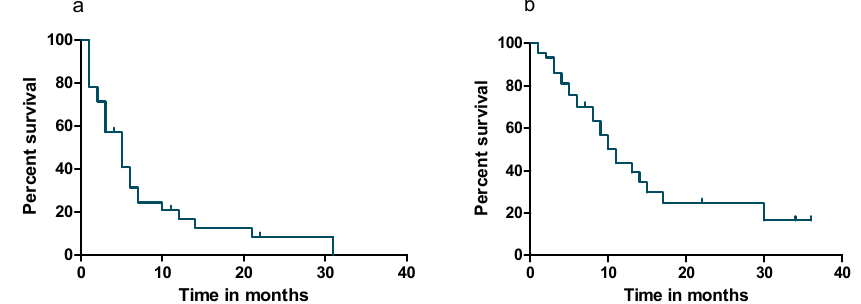
Figure 1. Progression-free survival (PFS) ( a ) ( n = 45) and overall survival (OS) ( b ) ( n = 45) of patients.